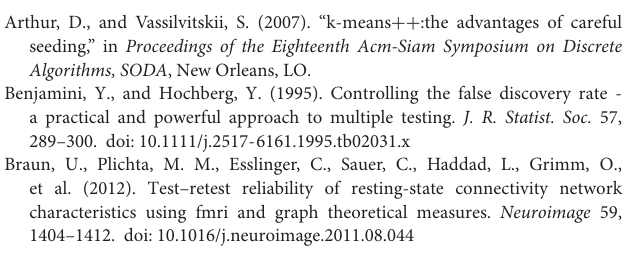
FIGURE S1 | Hypergraph. A hypergraph in which each hyperedge can connect more than two nodes. Here, the hypergraph consists of 8 nodes and 4